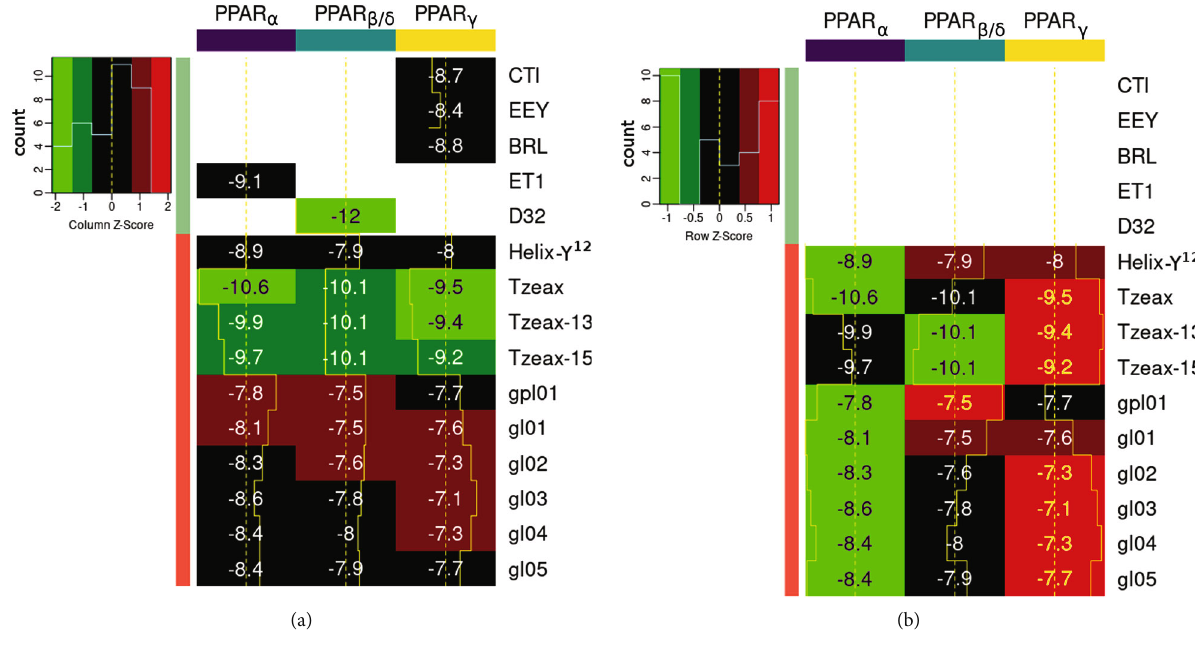
Figure 6: Target – ligand Δ G values (kcal/mol) at the biologically active cavity of PPAR α (purple), PPAR β / δ (blue), and PPAR γ (yellow). b Statistical Z -score analysis heat-map (a) for the ligand set (columns) and (b) for the target set